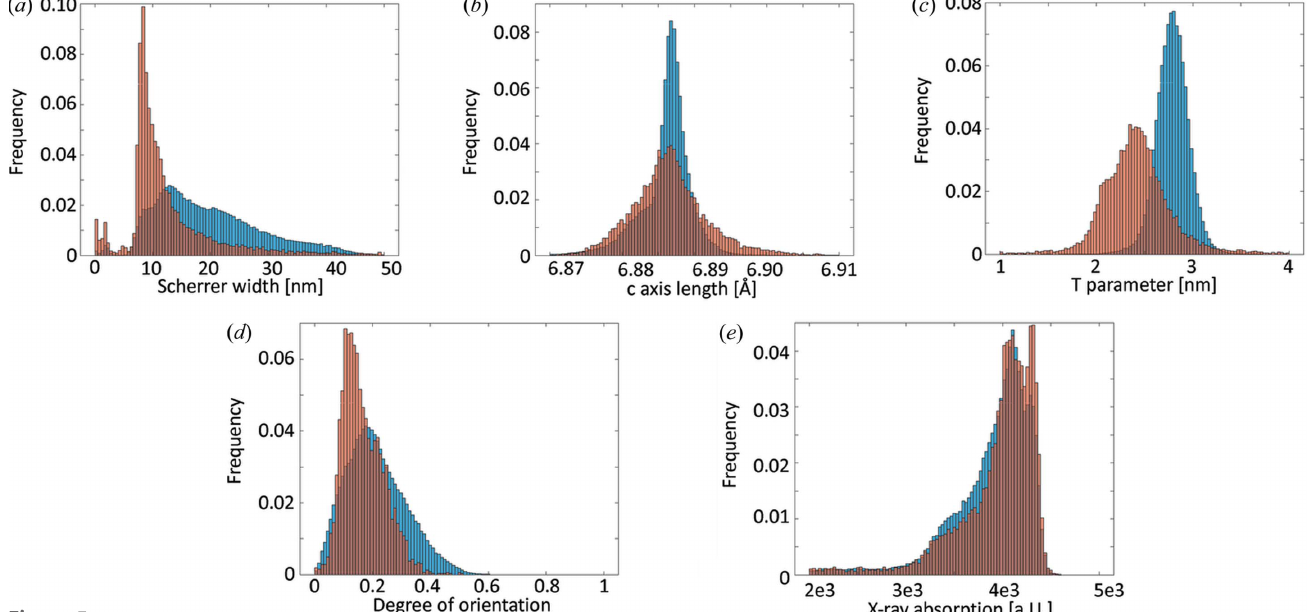
Figure 5 Histogram comparisons of cement line (red) and bone tissue (blue). ( a ) HAP (002) apparent crystallite size. ( b ) HAP c axis length. ( c ) T parameter. ( d ) Degree of orientation. ( e ) X-ray absorption.